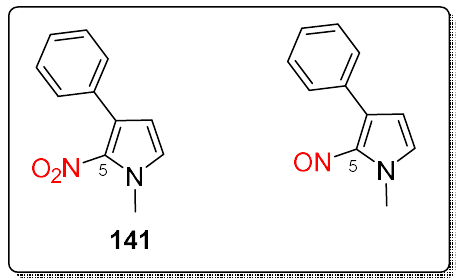
Figure 27. Chemical structure of 1-methyl-4-phenyl-5-nitroimidazole ( 141 ) and 1-methyl-4-phenyl-5-nitrosoimidazole ( 142 ).